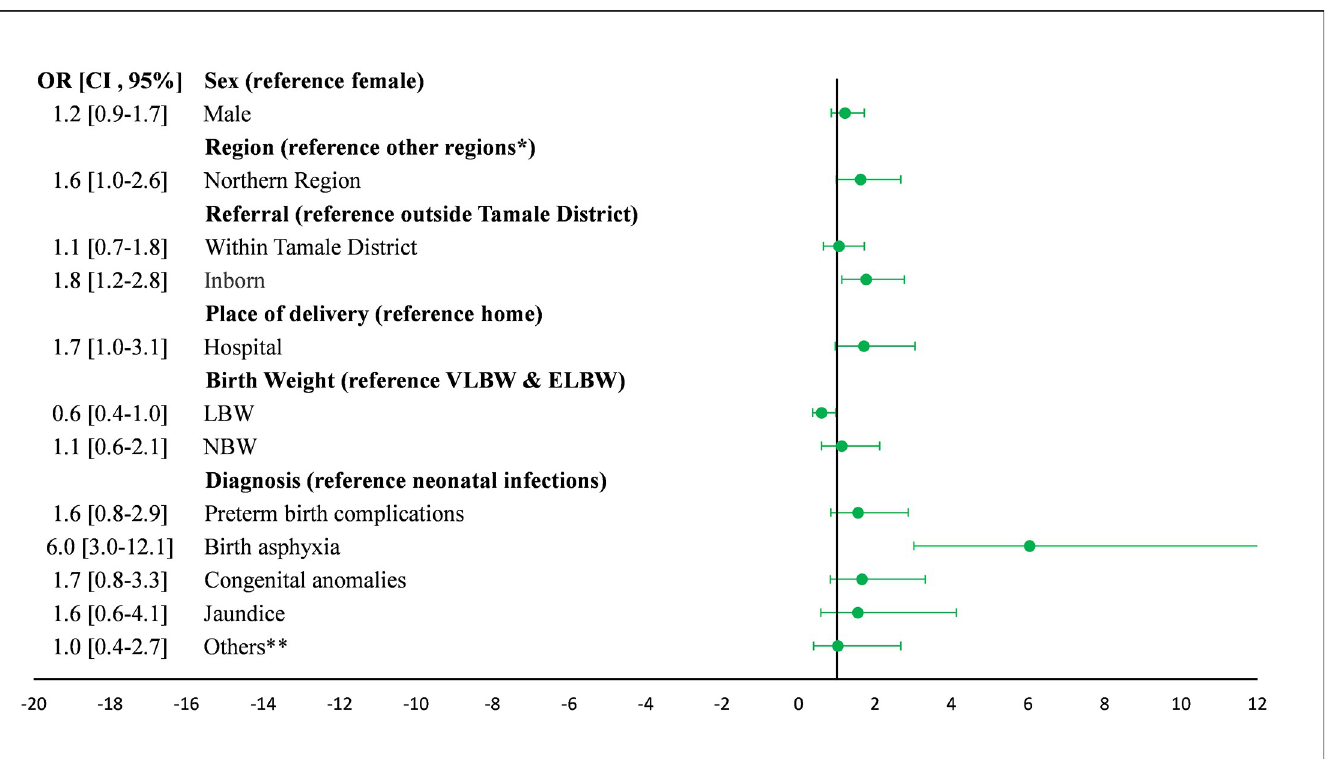
Fig 2. Predictors of early timing of neonatal death in NICU at Tamale Teaching